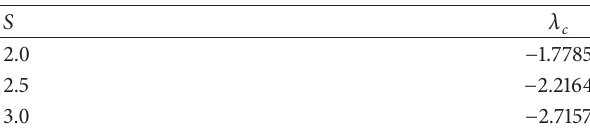
Table 1: Values of 𝜆 1𝑐 .